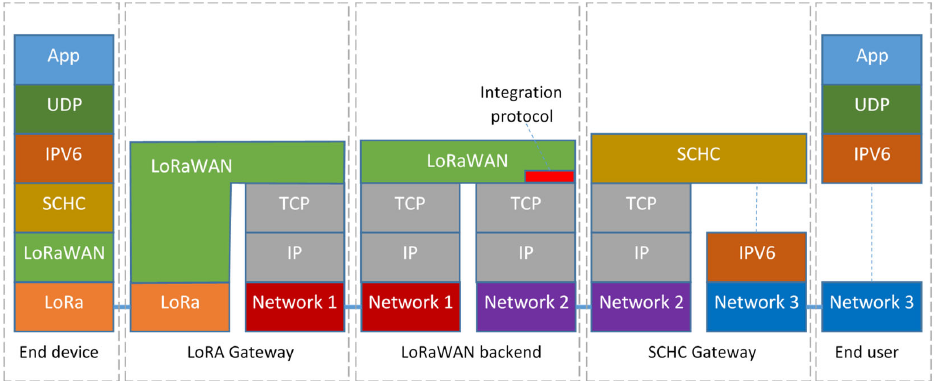
Figure 3. Example of encapsulation of the (TCP)UDP/IPv6 protocol in LoRaWAN networks via the SCHC adaptation layer.